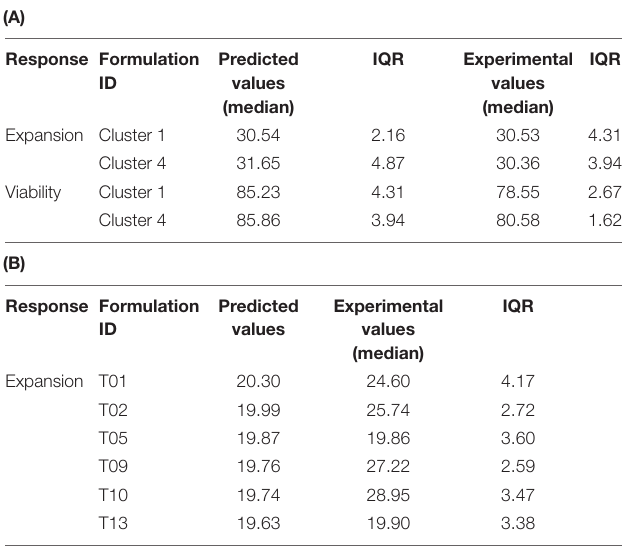
TABLE 3 | Comparison of predicted vs. experimental values of the test set for the individual models (median of n = 4 models) (A) and the single regression model of pooled data (B)